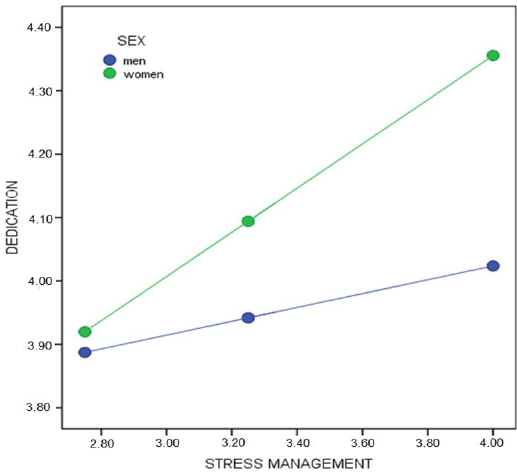
Figure 3. Conditional e ff ect of stress management on dedication by